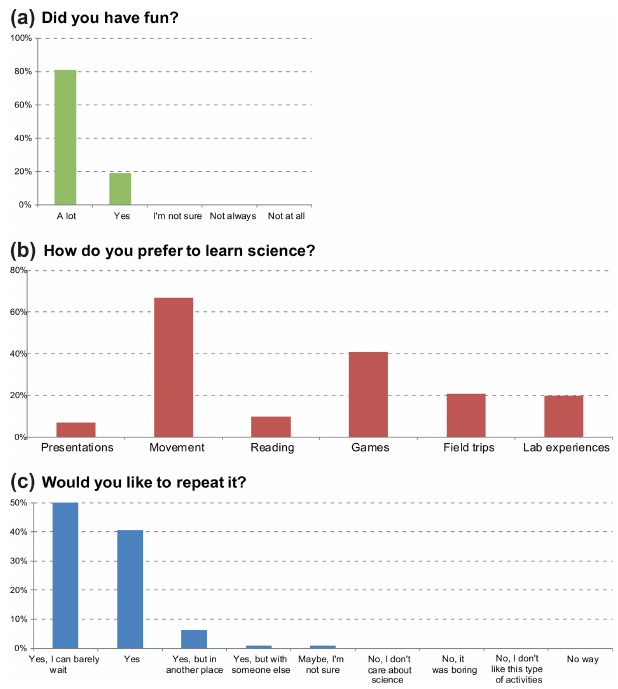
Figure 5. Results of enquiries for some of the questions. Note that for the question about how they prefer to learn about science mul- tiple responses were allowed, and the vertical axis is the number of responses and not a